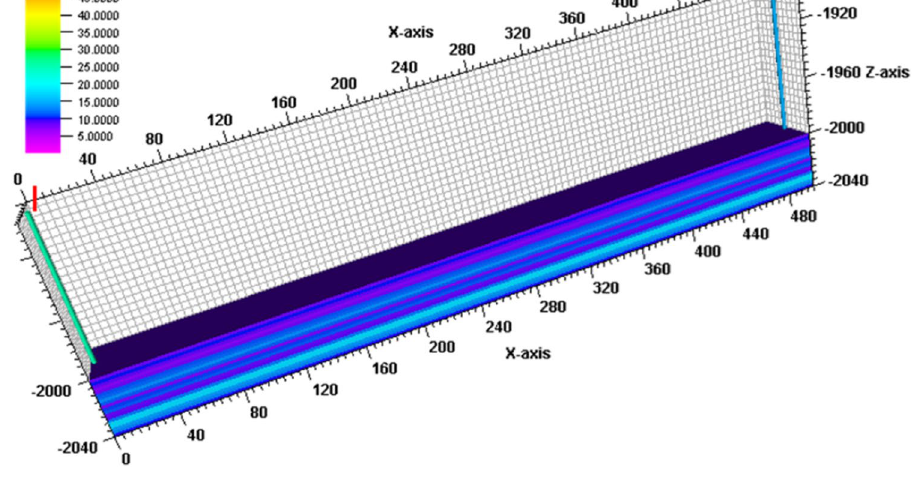
Fig. 4 Permeability distribution for 3D fully layered model